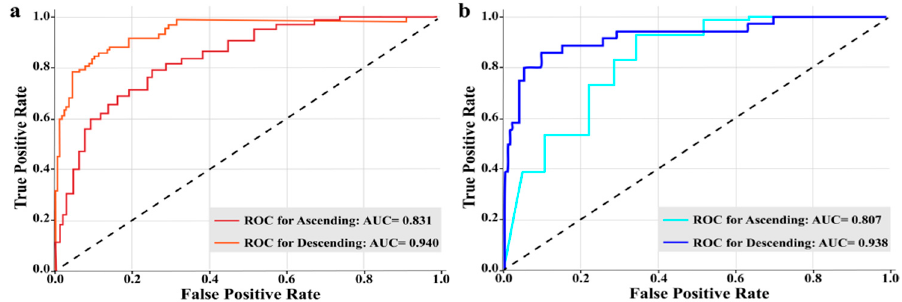
Figure 5. Area under the curve (AUC) of fine Gaussian support vector machine (SVM), ( a ) Kizilkeya; ( b ) Aktep.